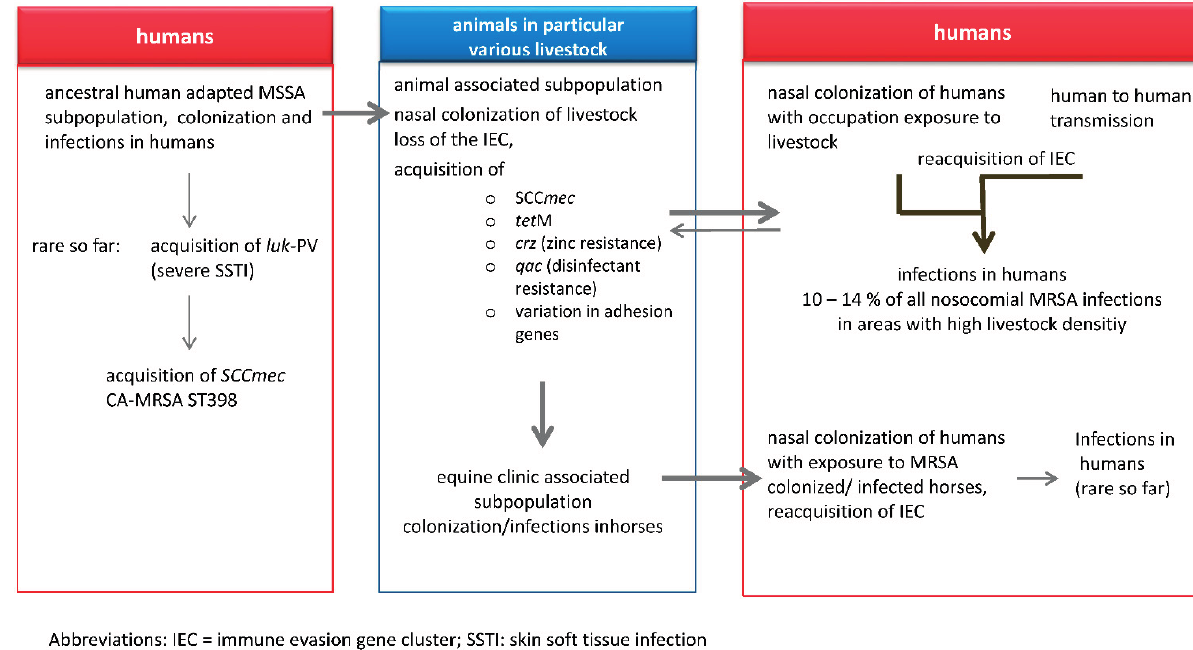
Figure 1. Staphylococcus aureus CC398 in humans and in